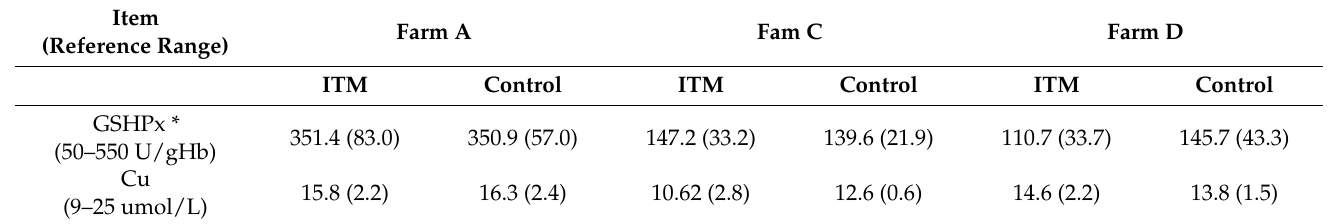
Table 1. Mean (SD) of blood GSHPx* and Cu levels pre-joining per treatment group.